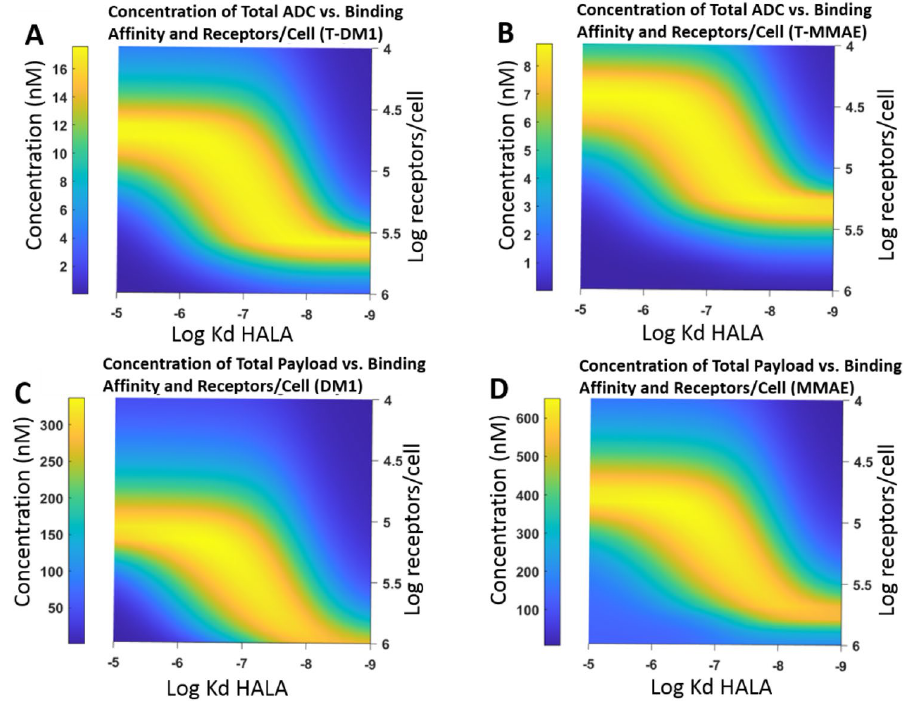
Figure 6. Design of optimal HALA with changing antibody dose and affinity after 48 h. Distribution of ADC and Payload of coadministered ADC HALA antibody with changing concentration and tumor expression in Krogh Cylinder simulations after 48 h. ( A ) Distribution of ADC at a dose of 3.6 mg/kg with DM1 payload (non-bystander) ( B ) Distribution of ADC at a dose of 1.8 mg/kg with bystander (MMAE) payload. ( C ) Payload distribution of ADC with non-bystander payload. ( D ) Payload distribution of ADC with bystander payload. Difference between ADC and Payload distribution is due to the ADC mostly being cleared at the end of the 48 h; however, payload is internalized and retained. Concentrations are shown at the Krogh cylinder radius, R Krogh , far from tumor blood